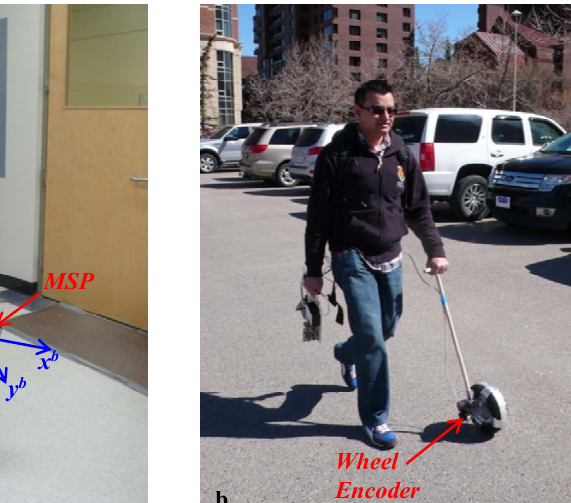
Figure 8. Test data collection